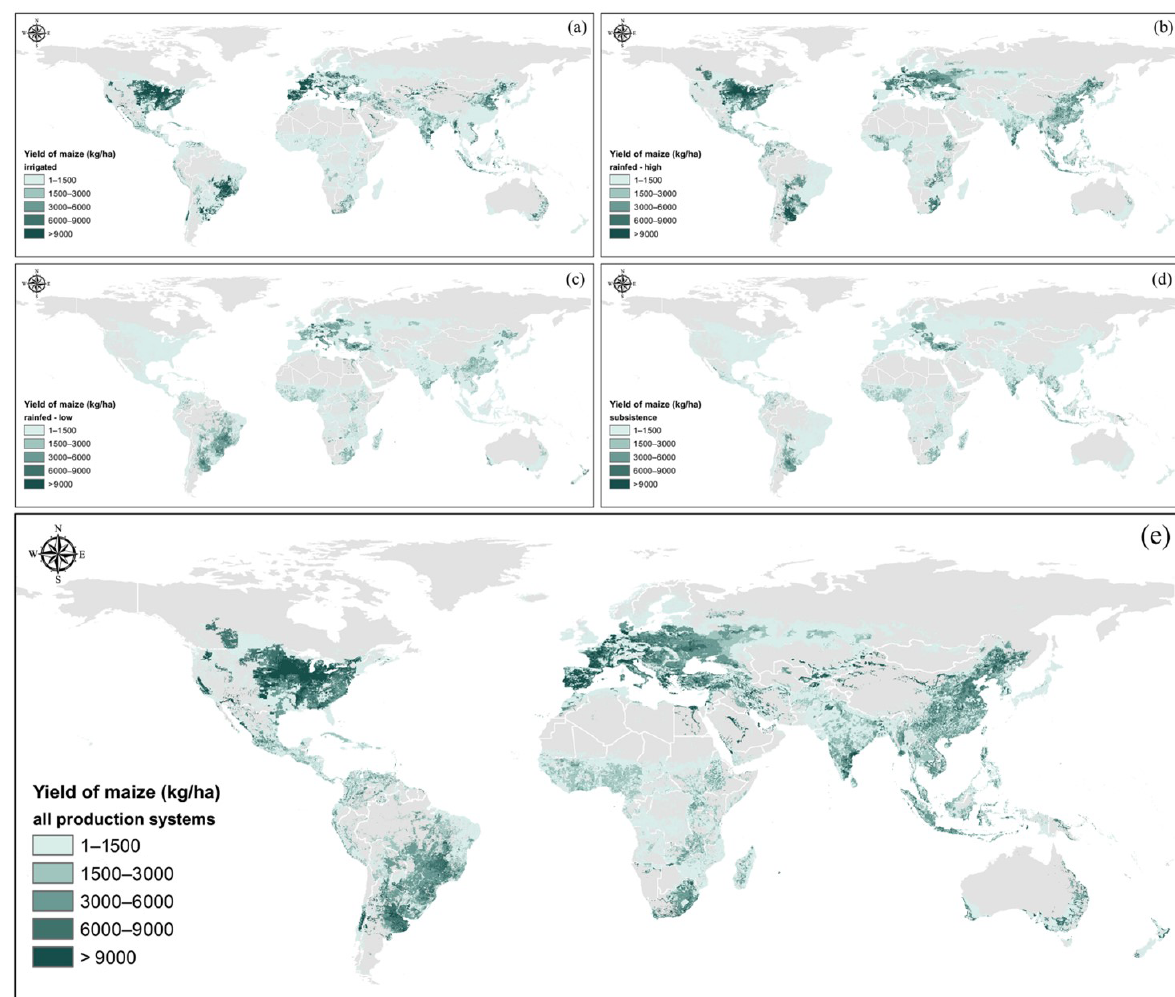
Figure 4. Yield maps for maize in irrigated (a) , rainfed–high (b) , rainfed–low (c) , subsistence (d) , and all (e) farming